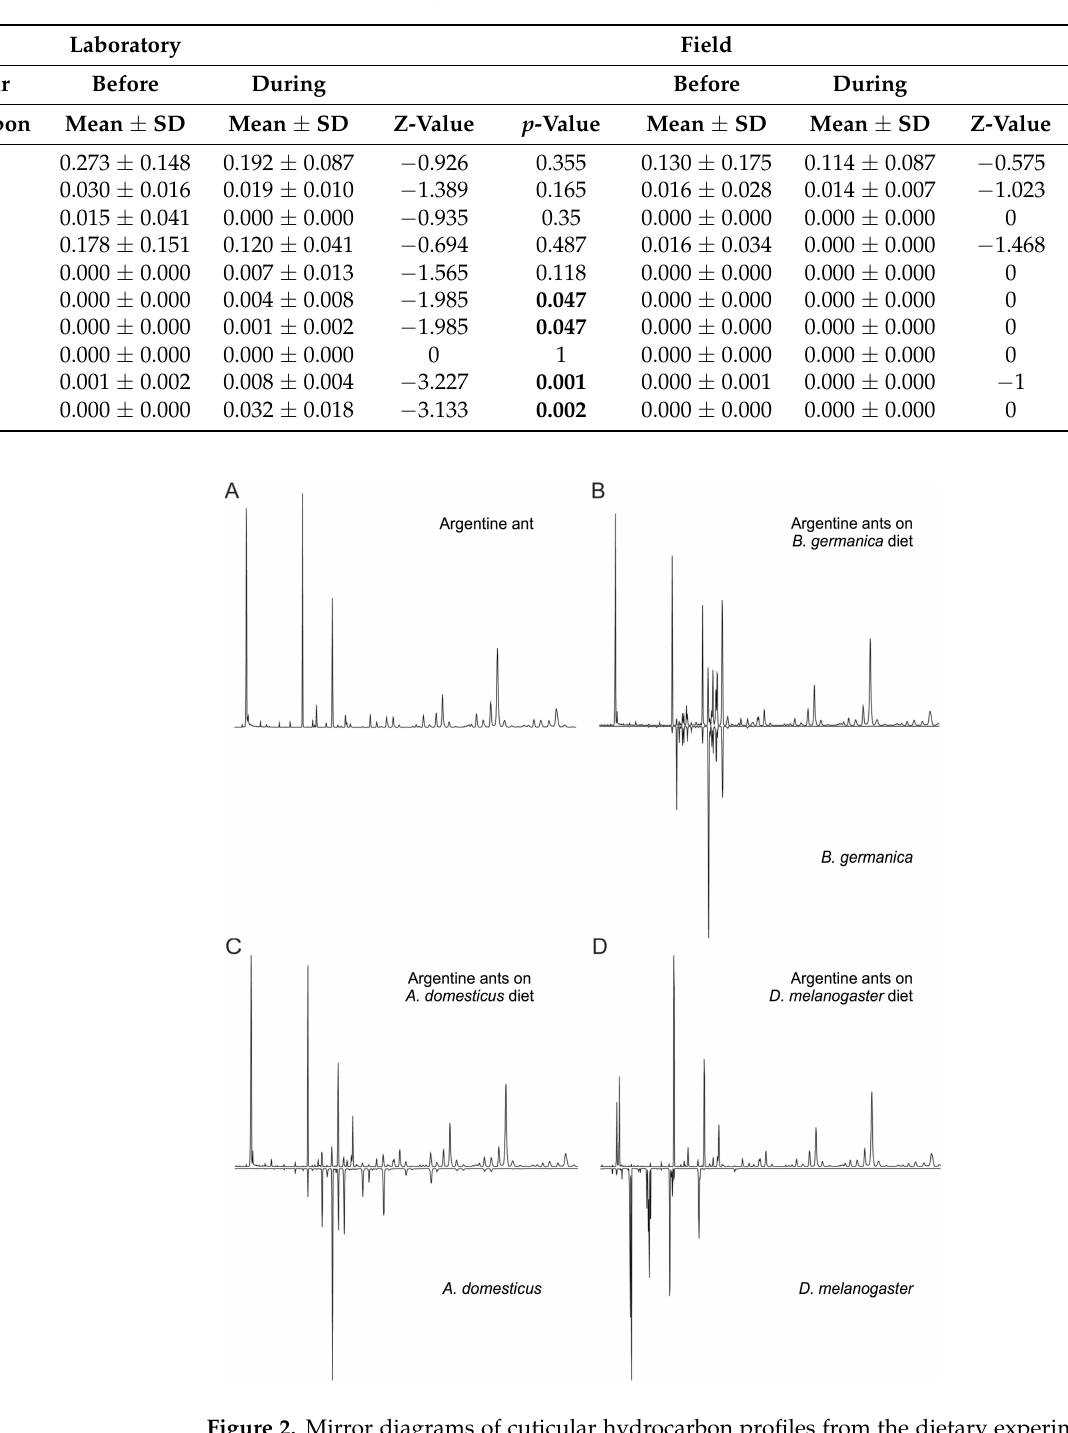
Figure 2. Mirror diagrams of cuticular hydrocarbon profiles from the dietary experiment. Upper profiles in each panel show cuticular hydrocarbon profiles of Argentine ants fed each type of insect diet; lower profiles are of the insect prey items themselves. ( A ) Unmanipulated Argentine ants, ( B ) Blatella germanica -fed Argentine ants ( top ) and B. germanica ( bottom ), ( C ) Acheta domesticus -fed Argentine ants ( top ) and A. domesticus ( bottom ), ( D ) Drosophila melanogaster -fed Argentine ants ( top ) and D. melanogaster ( bottom